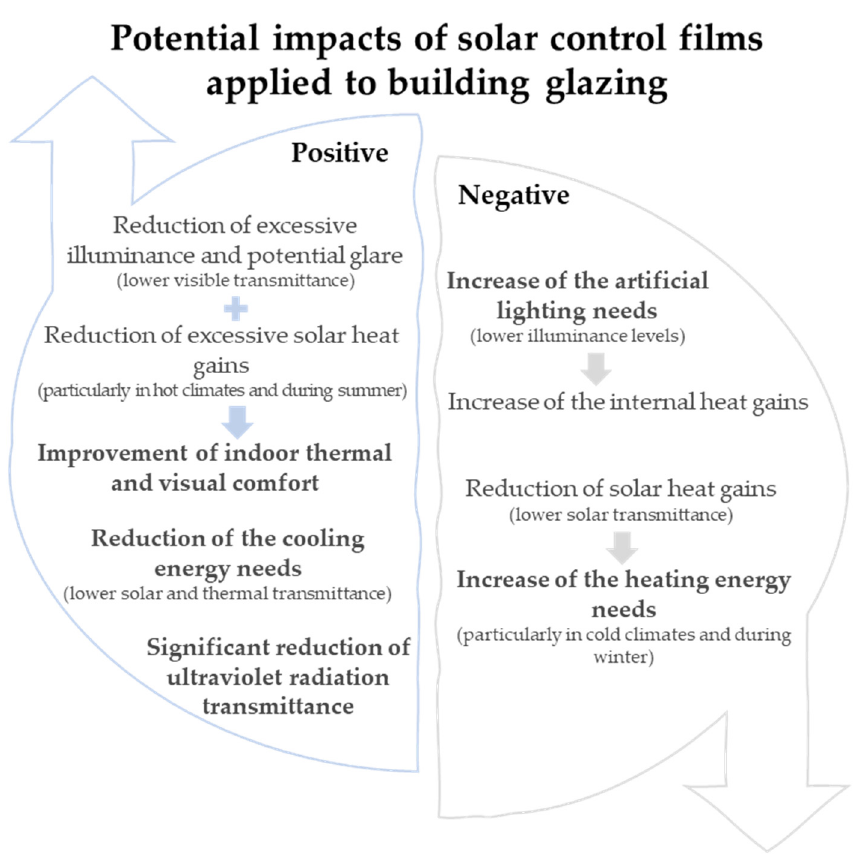
Figure 10. Potential positive and negative impacts of the application of solar control films to building glazing. ing